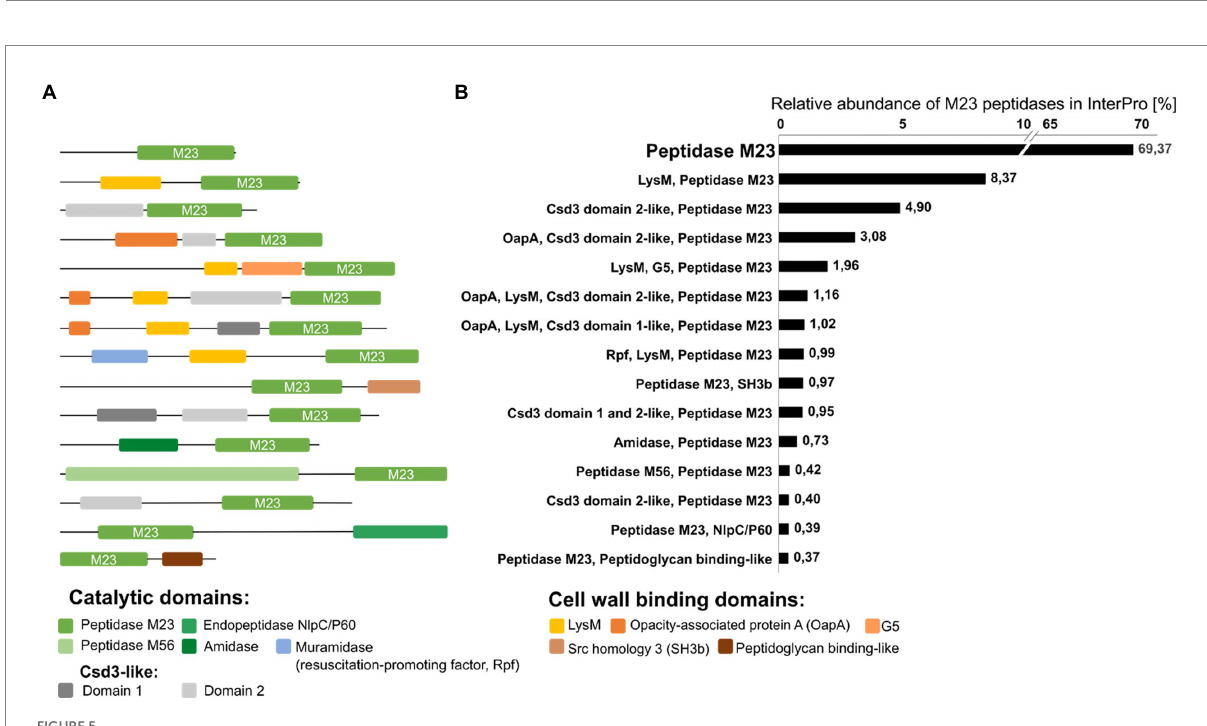
FIGURE 5 Schematic representation of the most common architectures of bacterial peptidoglycan hydrolases containing the M23 domain (A) and their relative abundance in percentage [%] among the peptidase M23 family of proteins in the InterPro database (over 90,000 sequences with at least 37% amino acid sequence identity of M23 peptidase domain with the lysostaphin M23 domain were included in the